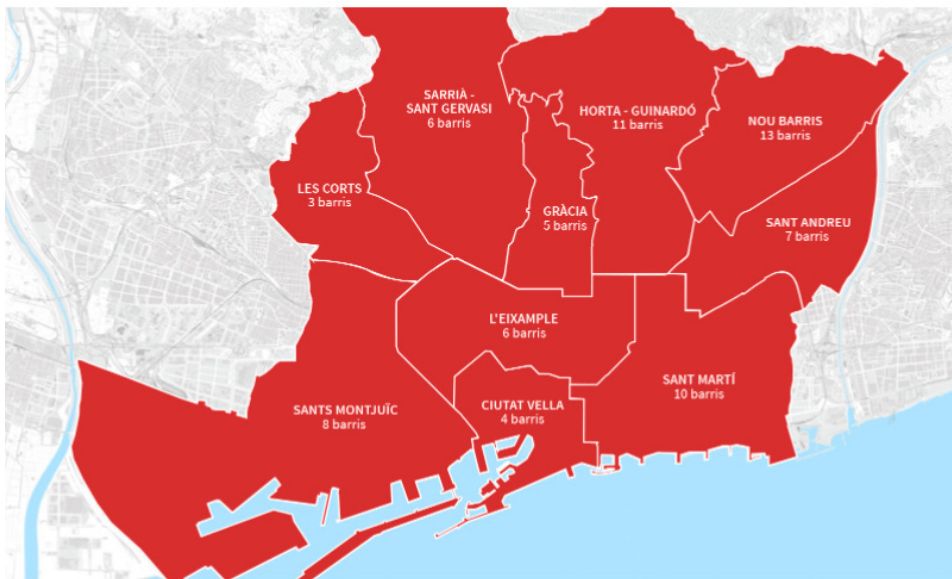
Figure 1. Barcelona Map. Available online: https://www.barcelona.cat/ca/viure-a-bcn/fem-barri (accessed on 11 November 2021).